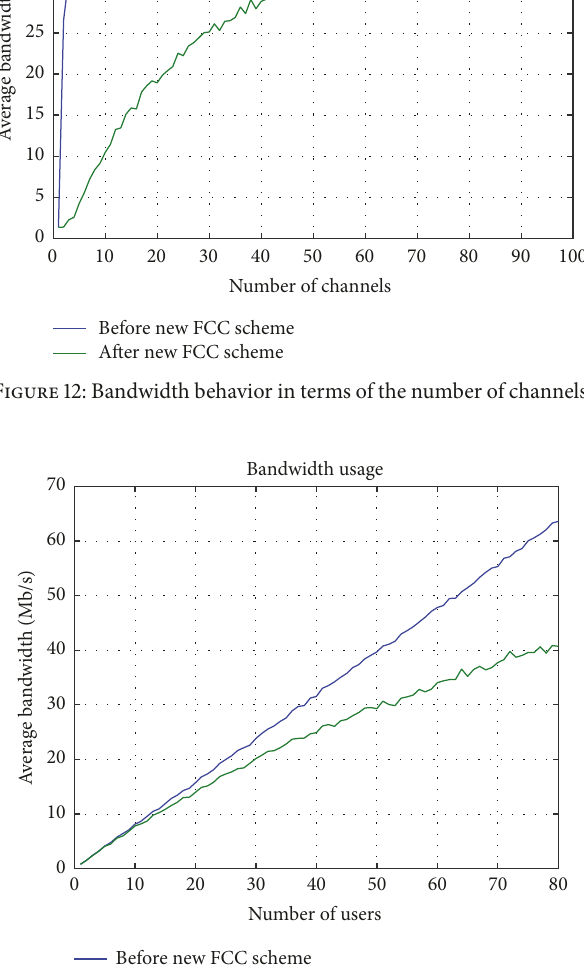
watching the same channel, which can support sending the unicast stream instead of the central FCC server.